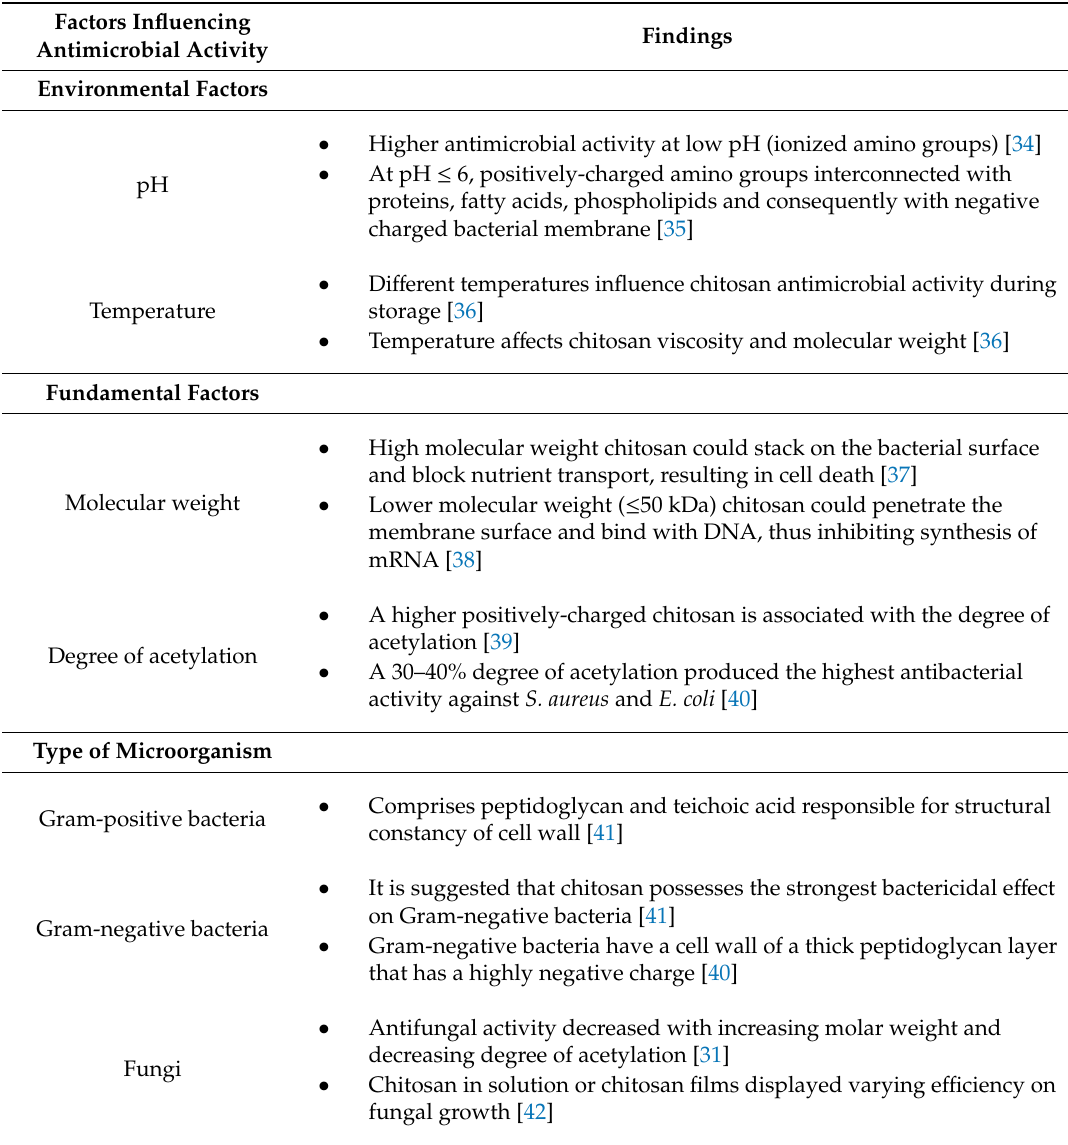
Table 2. Influence of three main factors a ff ecting the antimicrobial activity of